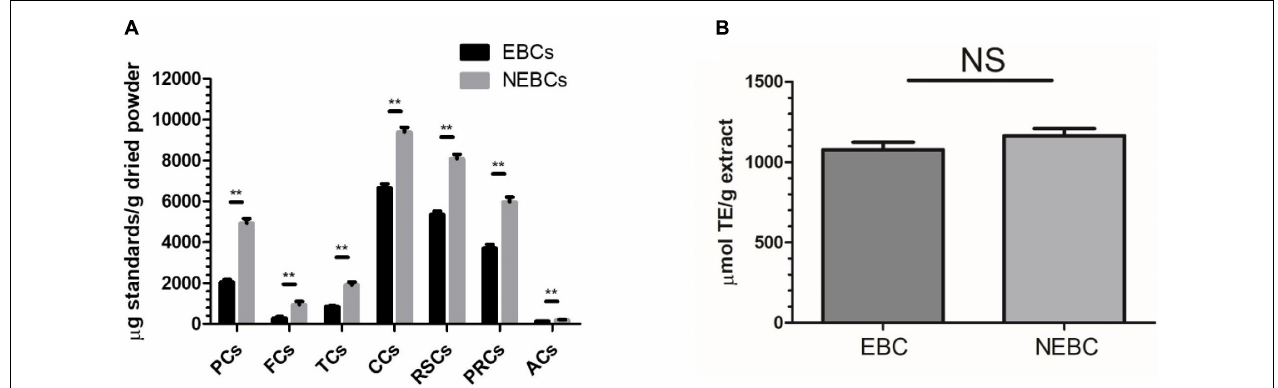
FIGURE 1 | (A) The total phenolics contents (PCs), flavonoids contents (FCs), tannin contents (TCs), carbohydrate contents (CCs), reducing sugar contents (RSCs), anthocyanin contents (ACs), total protein contents (PRCs) in the EBCs and NEBCs. (B) The ORAC value of the EBCs and NEBCs. Data were presented as mean ± SD ( n = 3), ** indicates P < 0.01. TABLE 1 | Phenolic compounds quantified in extractable bioactive components (EBCs) and non-extractable bioactive components (NEBCs) from Gracilaria rubra. Compound